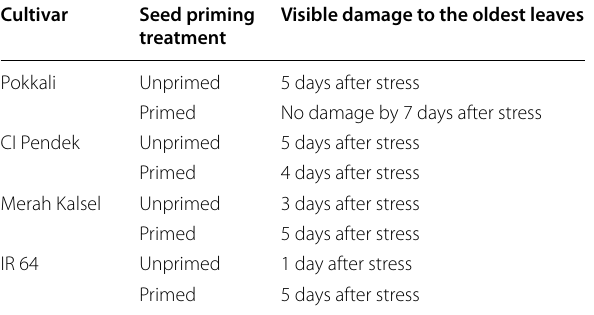
Table 4 Seed priming greatly increased salinity tolerance of IR 64 seedlings, as measured by SES score 7 days after salinity